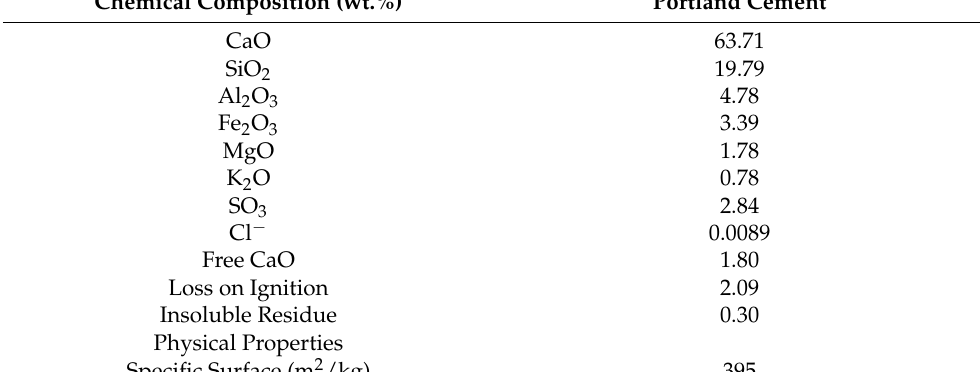
Figure 1. The particle size distribution of Portland cement. Table 1. Chemical compositions and selected physical properties of Portland cement. Chemical Composition (wt.%)